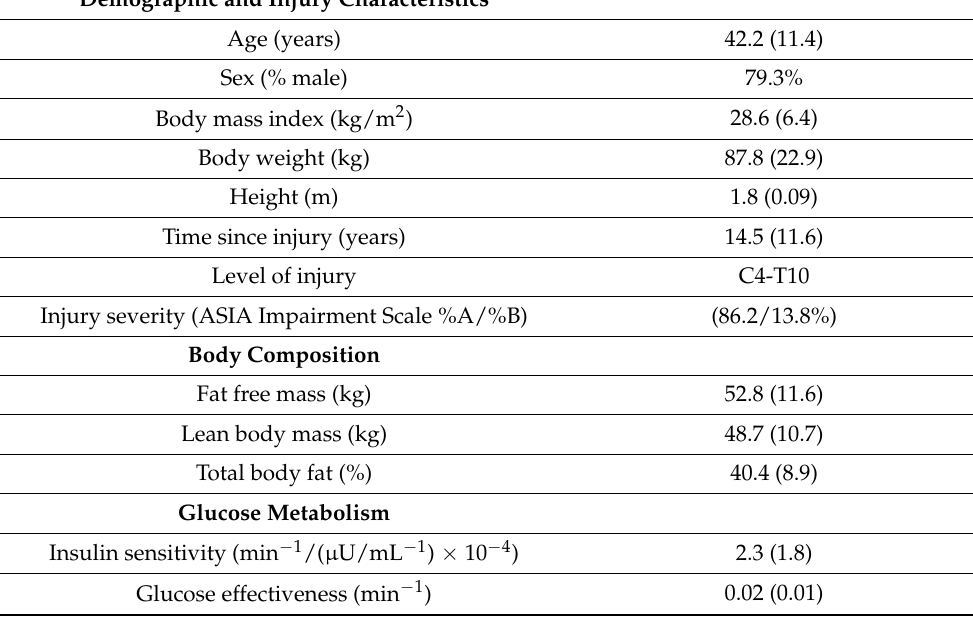
Table 2. Demographic, body composition, and glucose metabolism data in persons with chronic motor complete SCI ( n =